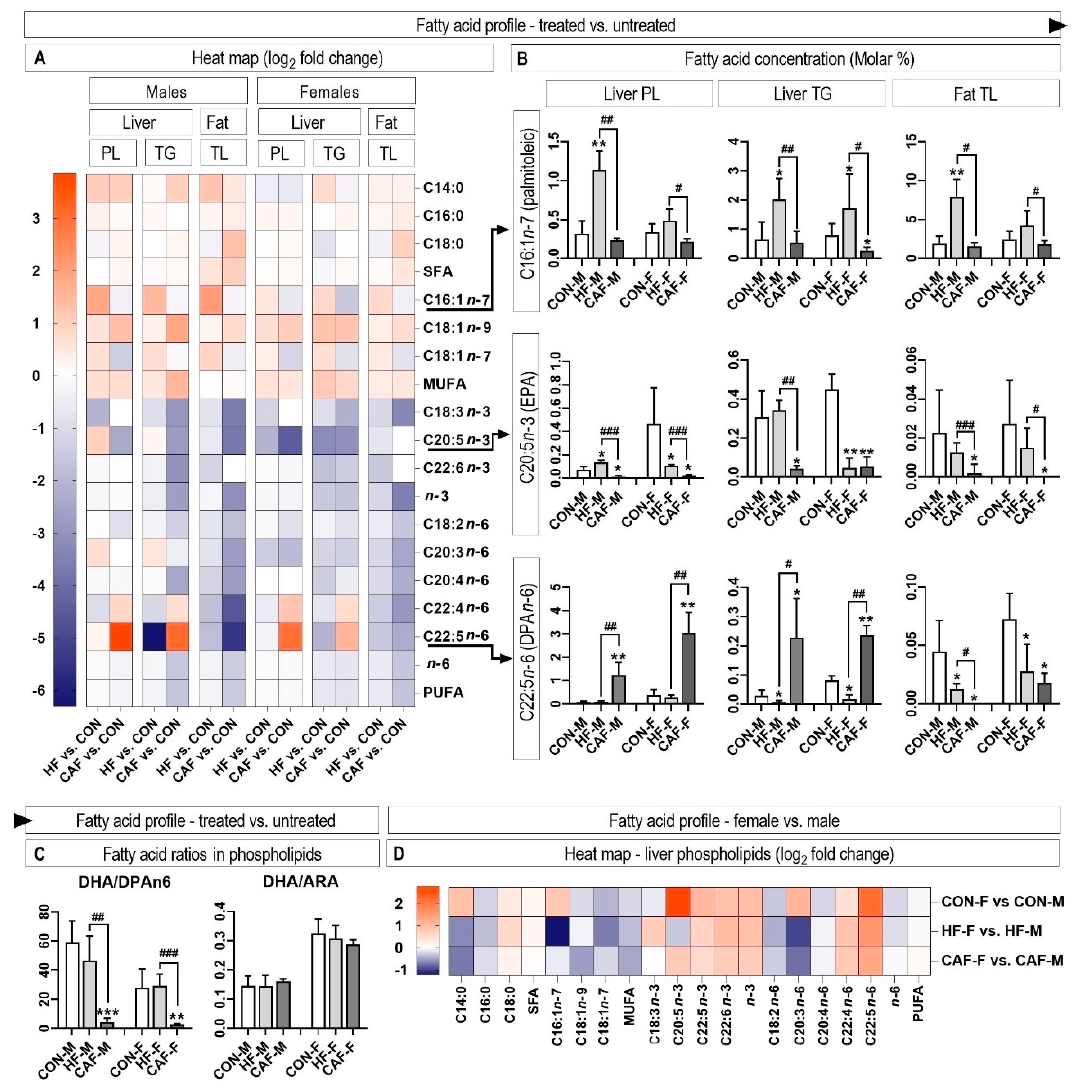
Figure 4. The influence of the treatments on the fatty acid profile of the hepatic phospholipids and triglycerides and perirenal total fat is presented as a heat map ( A ). The most characteristic fatty acids (C16:1 n -7, C20:5 n -3 and C22:5 n -6) are presented as the molar percentage ( B ). Additionally, two important ratios of DHA/DPA n -6 and DHA/ARA are presented ( C ). The influence of sex in different treatments is presented as a heat map ( D ). * p < 0.05, ** p < 0.01, and *** p < 0.001 for the treatment versus the Control within the same sex. # p < 0.05, ## p < 0.01, and ### p < 0.001 for the HF diet versus the CAF diet within the same sex. n = 6 for each group. PL, phospholipids; TG, triglycerides; TL, total lipids. CON, control diet; HF, high-fructose diet; CAF, cafeteria diet; M, males; F, females.